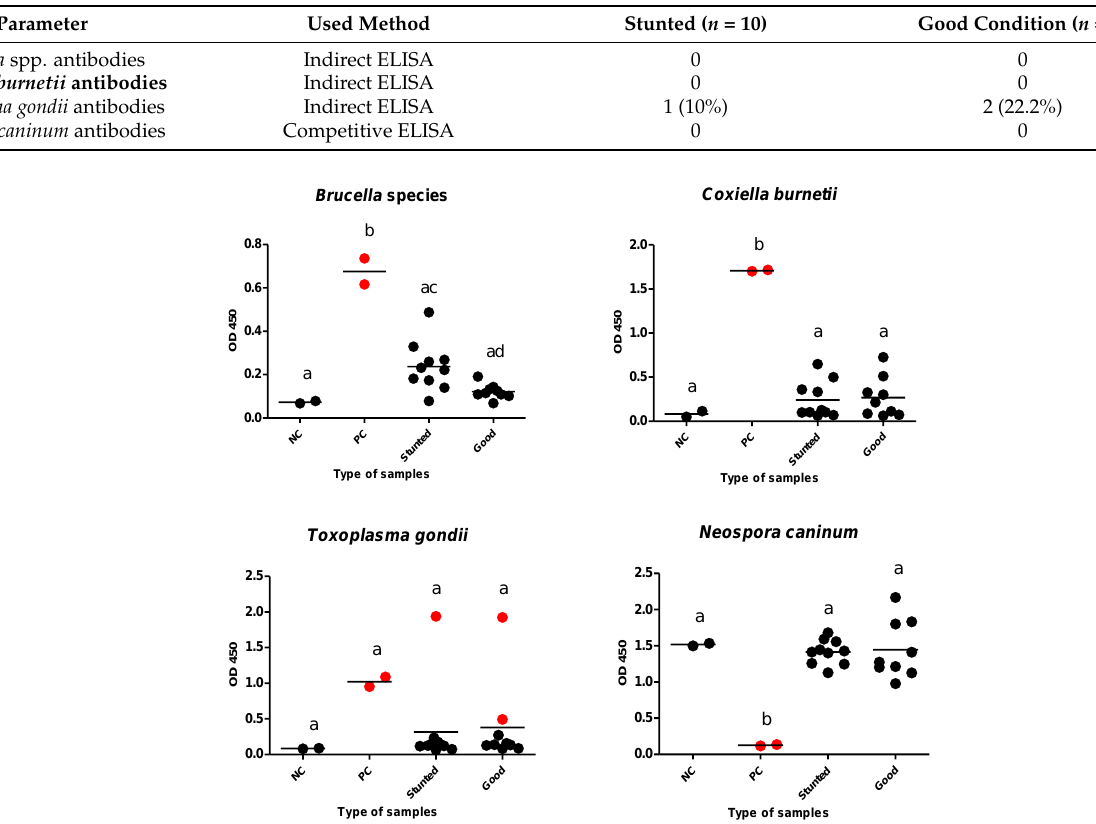
Figure 7. Different ELISAs for examined Barki sheep. Sera from stunted ( n = 10) and good body condition ( n = 9) Barki sheep were tested using a commercial ELISA for detection of specific antibodies against Brucella species, Coxiella burnetii , Toxoplasma gondii , and Neospora caninum and for significant differences in different sera against the same tested antigen. Each bar represents the mean ± standard deviation. The different letters above the bars in the graphs indicate statistically significant differences of other groups (one-way ANOVA with Tukey – Kramer post hoc analysis, p < 0.05 ). Red dots refer to positive samples either from the control or test samples. NC; negative control, PC; positive control.